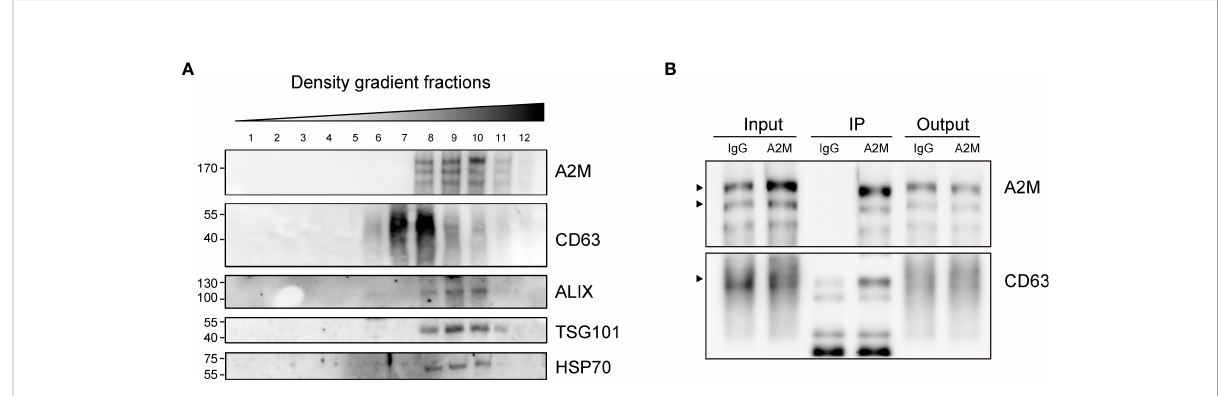
FIGURE 7 Co-fractionation of a2M with EV markers. (A) Density gradient fractionation of urinary EVs from bladder cancer patient. After fl otation of the sample in high-resolution iodixanol gradients, equal volumes of each fraction were loaded on SDS-PAGE gels, and membranes were blotted with the indicated antibodies. (B) Immunoprecipitation (IP) of urinary EVs from a bladder cancer patient with a2M-speci fi c antibody-conjugated beads (a2M). Rabbit IgG (IgG) was used as a negative control for precipitation. Input: urinary Evs from a bladder cancer patient before IP reaction. IP, protein lysate of immunoprecipitated urinary EVs with antibody-conjugated beads. Output: fl ow-through proteins from the IP reaction. The precipitated proteins were analyzed via immunoblotting with an anti-a2M or anti-CD63 antibody. The expected protein sizes are indicated by black arrows.